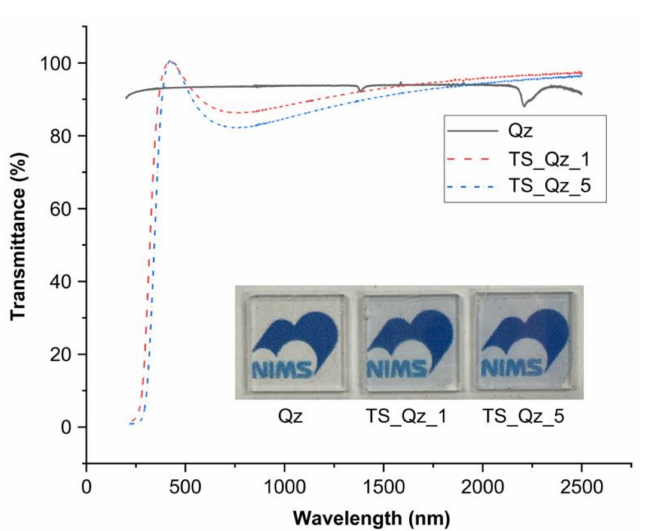
Figure 4. The transmittance of the nanoscale layered TiO 2 /SiO 2. Inset: images of the corresponding